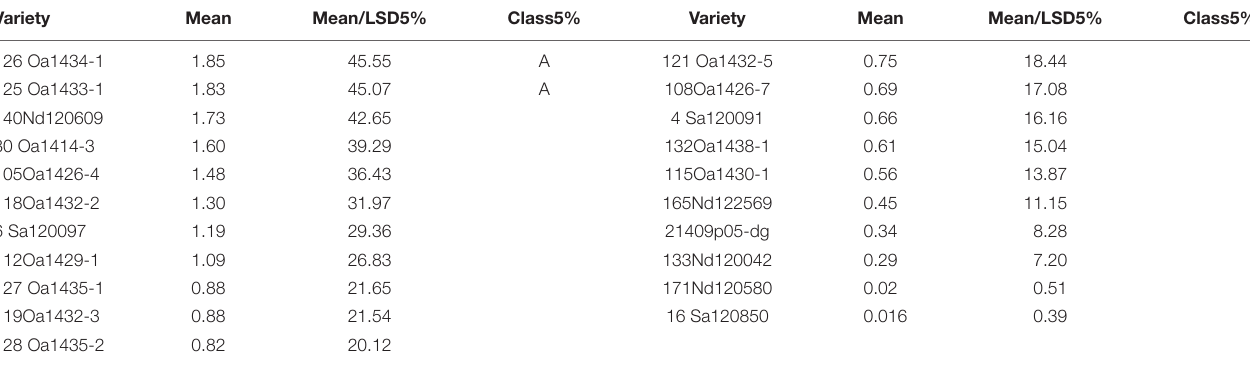
TABLE 4 | The top 21 genotypes out of 248 for germination rates under salt and alkali stresses.